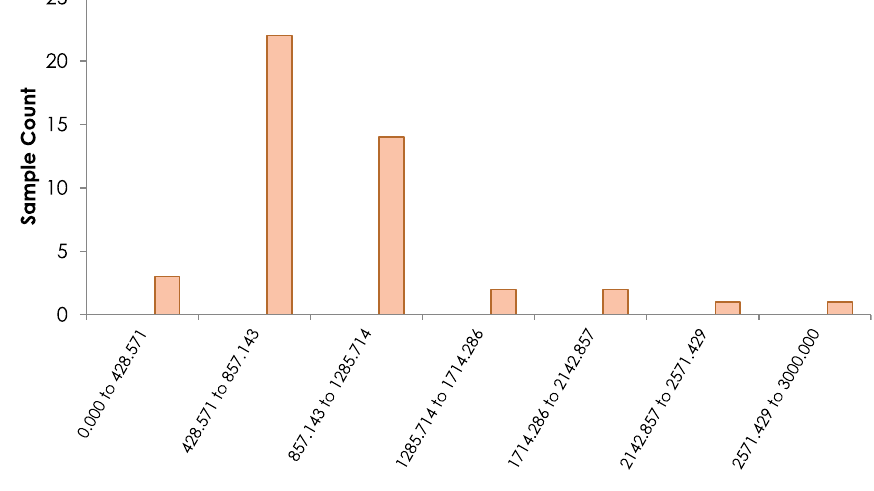
Fig. 4 Cu histogram for the Musina mine tailings